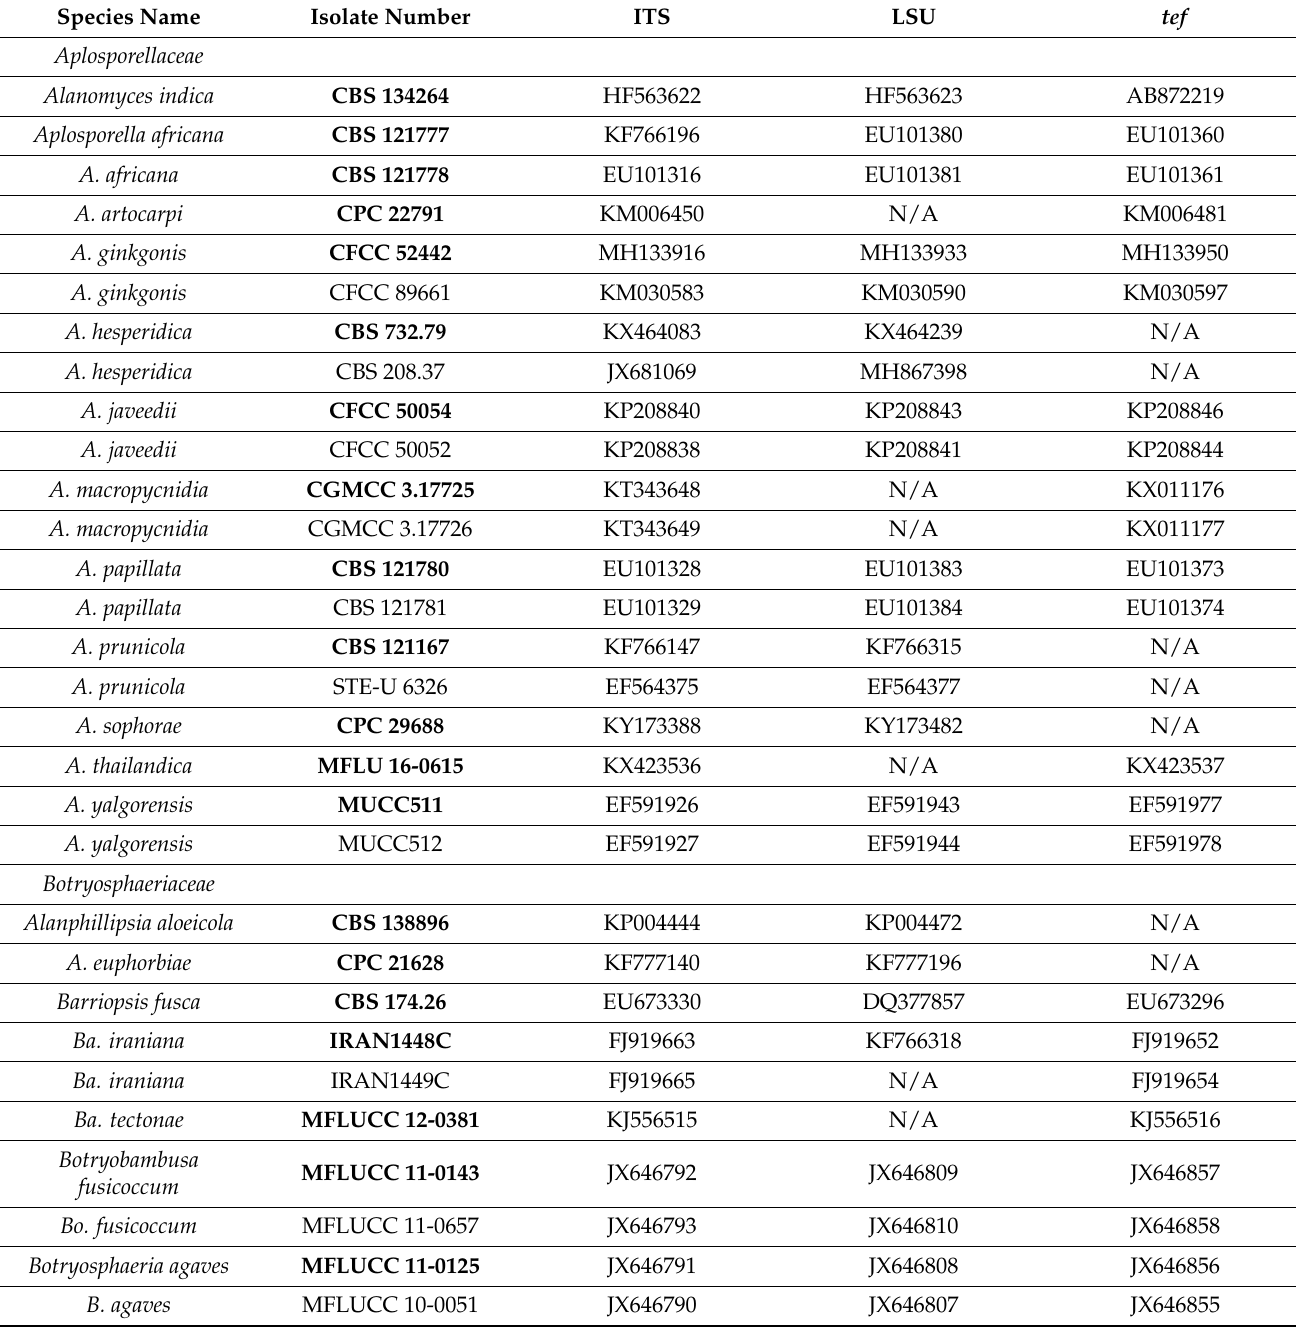
Table 3. Botryosphaeriales taxa used in the phylogenetic analysis. The culture collection accession number for the type strains are given in bold. N/A: No sequence